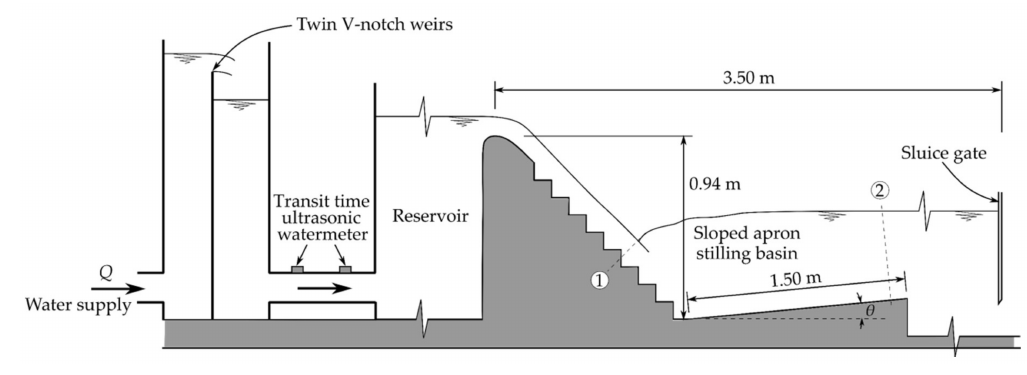
Figure 2. Experimental